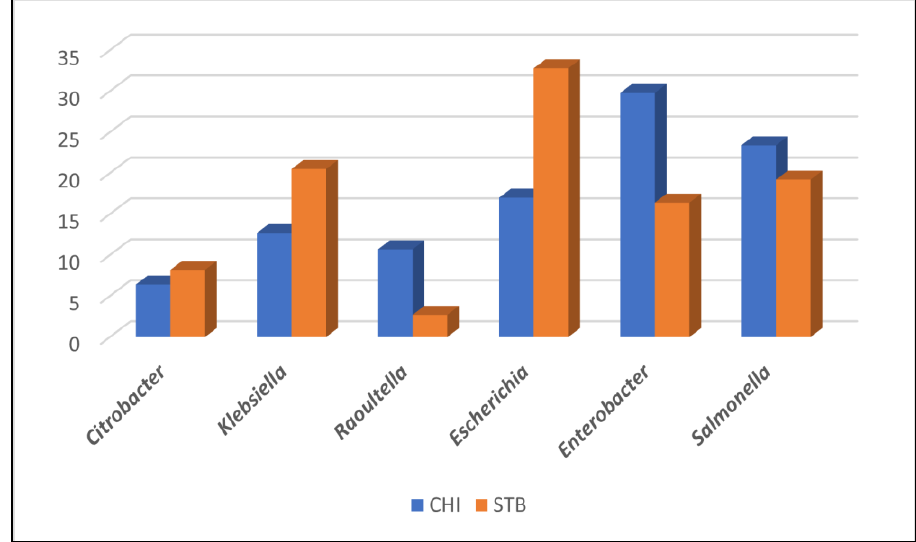
Figure 3. Isolation frequency (%) of the dominant enterobacterial genera obtained from cloacal swabs sampled at the Chancel Island (CHI) and Saint Barthélemy (STB) sites.